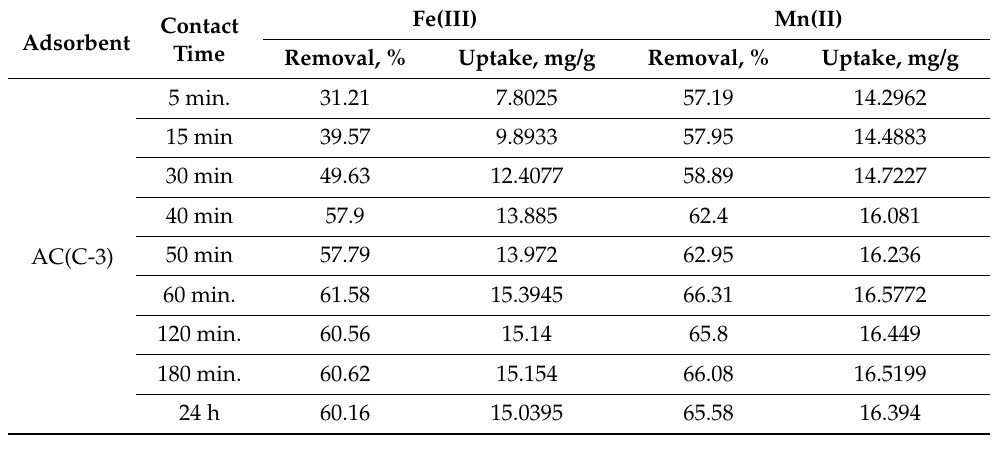
Table 6. The influence of contact time on the absorption and removal by AC(C-3) of Fe(III) and Mn(II) from aqueous solutions (conc. = 50 mg/L, time = 24 h, wt. = 0.05 gm, agitation velocity = 100 rpm and temp. 25 ◦ C) by percentage.